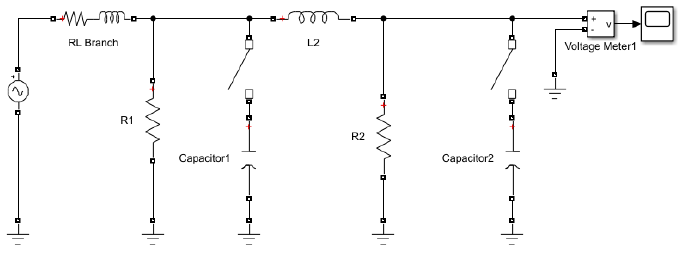
Figure 3. Simulink system for generating voltage oscillatory transient induced by capacitor